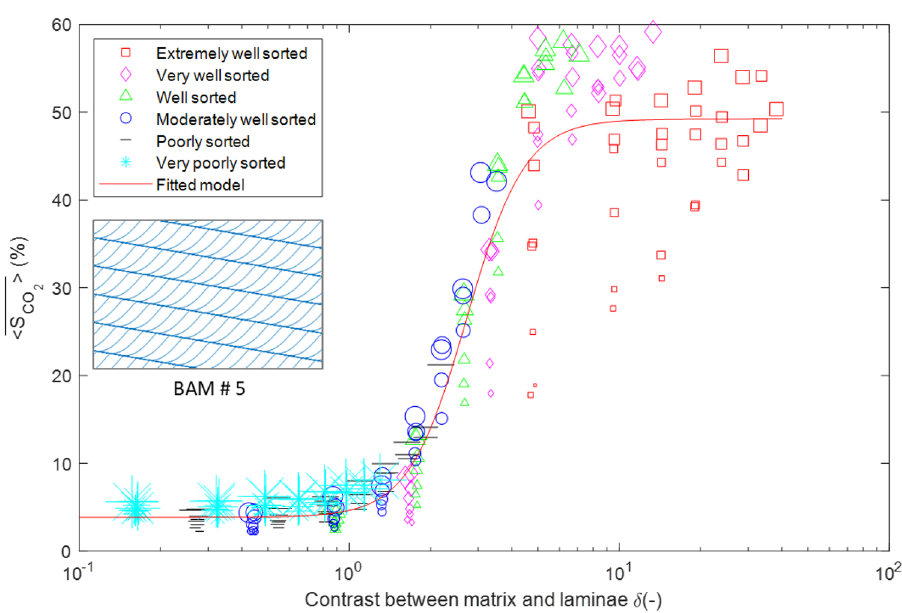
Figure 7. Mean domain CO 2 saturation data and the fitted model for BAM #5 for all 270 grain size contrast cases. The inset graph shows the cross lamination pattern for BAM #5. The size of the symbols represents the laminae mean threshold capillary pressure (m. as defined in Eq. (7)). For more figure description, see Fig.